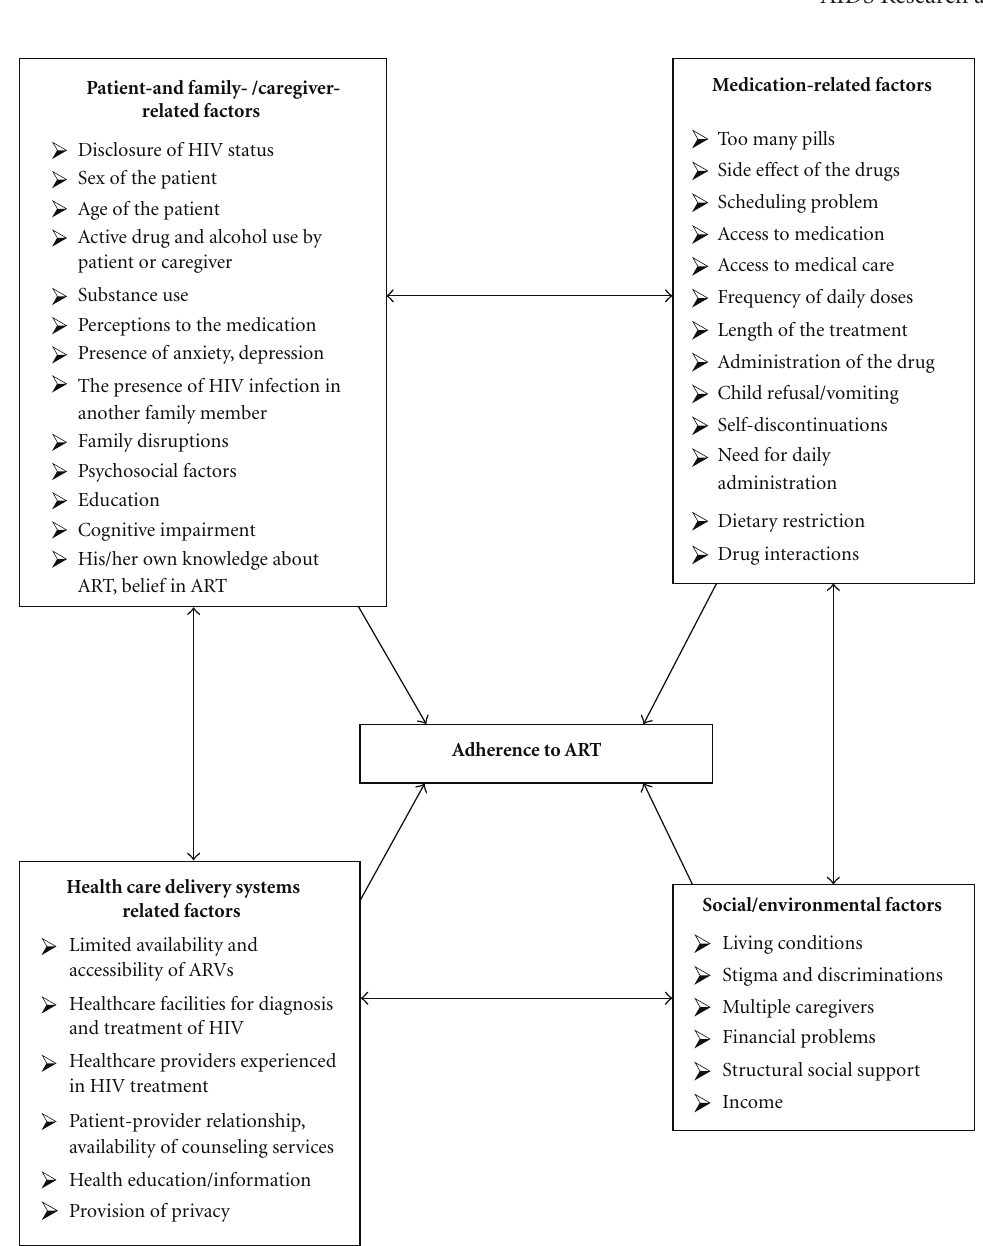
Figure 1: Identified factors for the challenges of adherence to